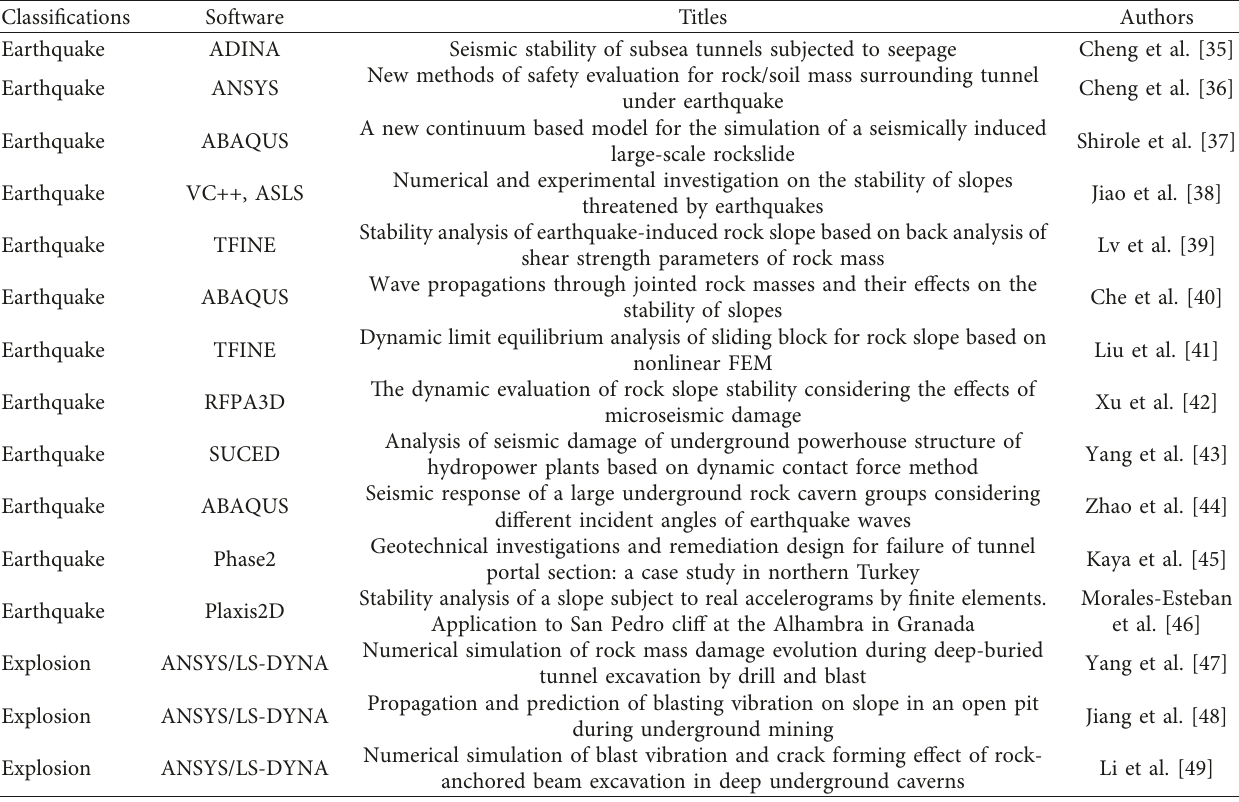
Table 1: Applications of the FEM in dynamic stability analysis of